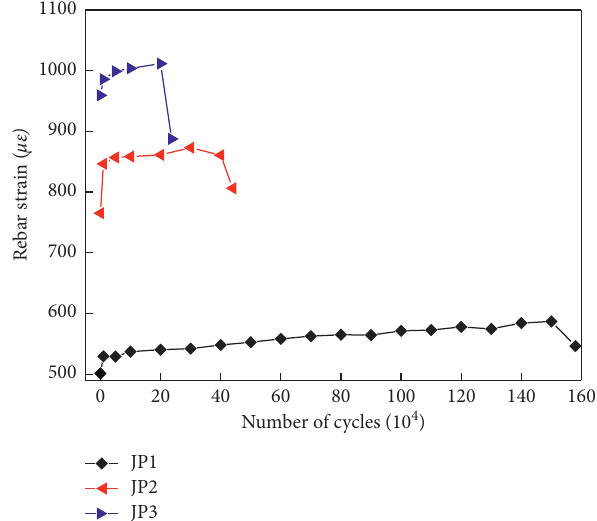
Figure 15: Relation curve for longitudinal tensile rebar and fatigue cycles.